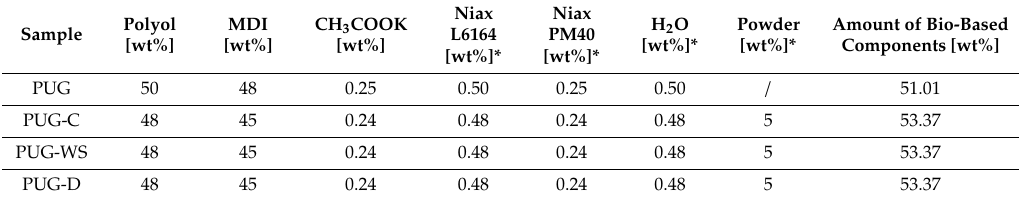
Table 1. PUG (Pristine polyurethane foam) and Composite foams formulations ([wt%]* with respect